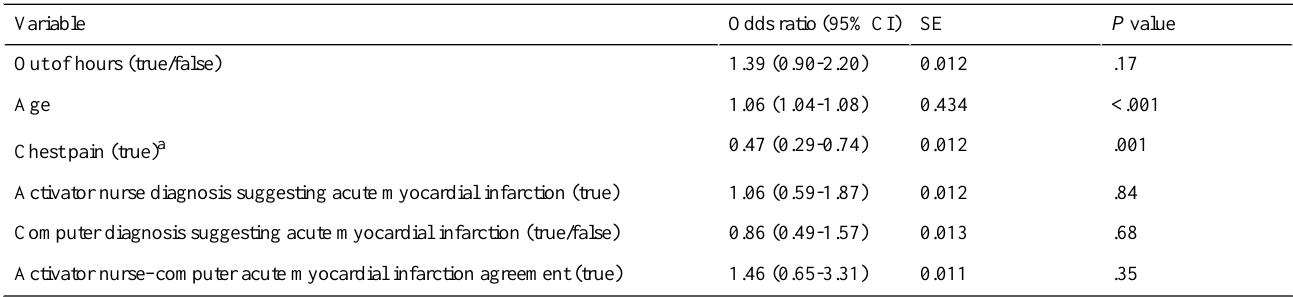
Table 2. Odds ratios of variables derived from multiple logistic regression where the response variable was mortality after 30 days.